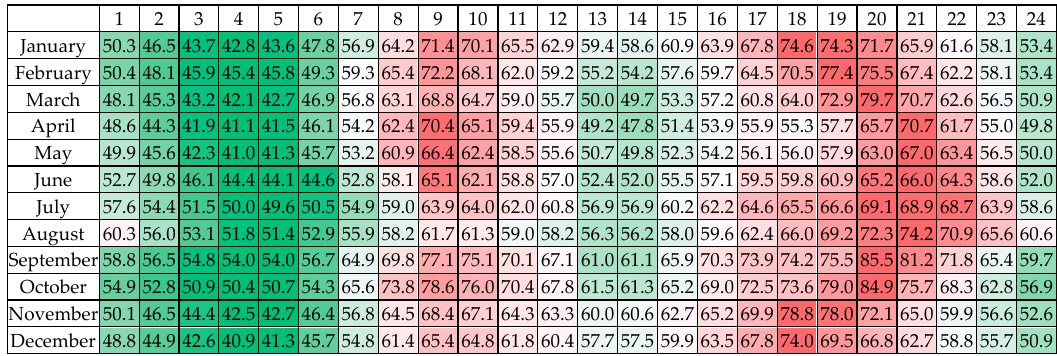
Figure 13. Average PUN Index trend over the reference months: weekdays. (Green: low; White: medium; Red: high).